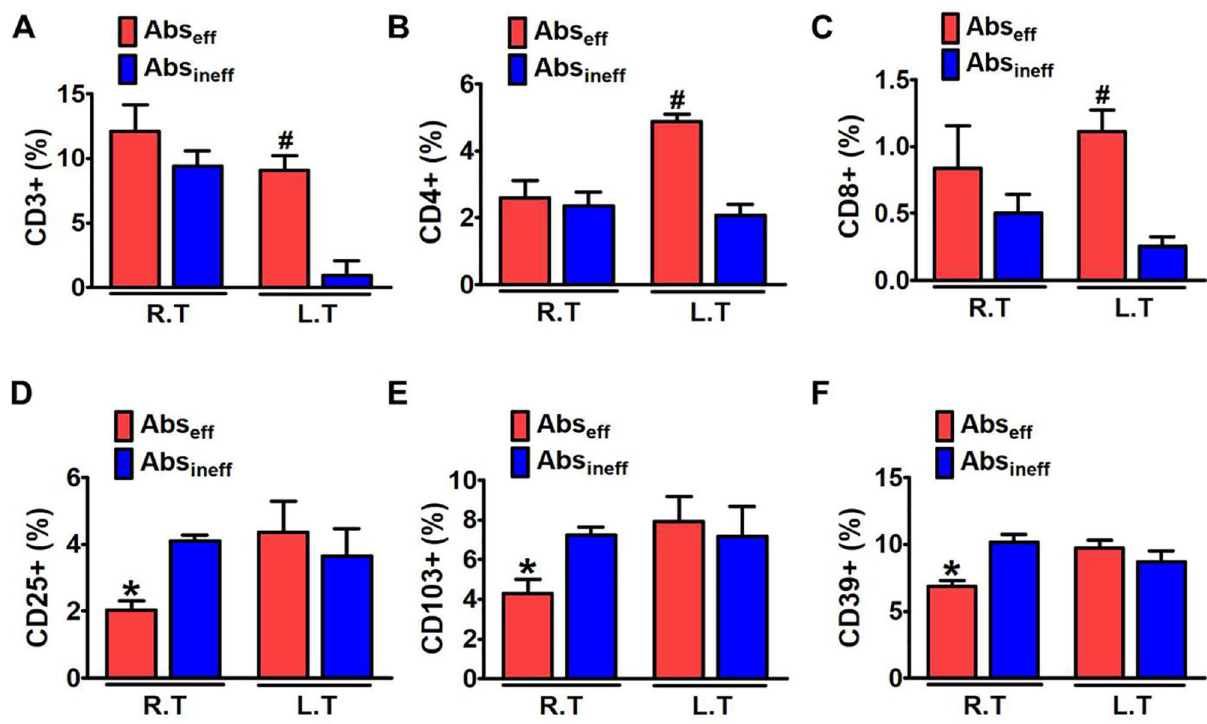
( D ) CD25 + ( E ) CD103 + , and ( F ) CD39 + T cells, isolated from the irradiated right and non-irradiated left tumor in Abs eff group and Abs ineff group. After 28 days of tumor cell injection, T cells within tumors were isolated from Panc02 pancreatic cancer bearing mice. Data are from an experiment representative of three mice in the effective and four mice in the ineffective group. * P < 0.05 compared to right tumor. #P < 0.05 compared to left tumor (by one-way ANOVA with Tukey’s post hoc test for multiple